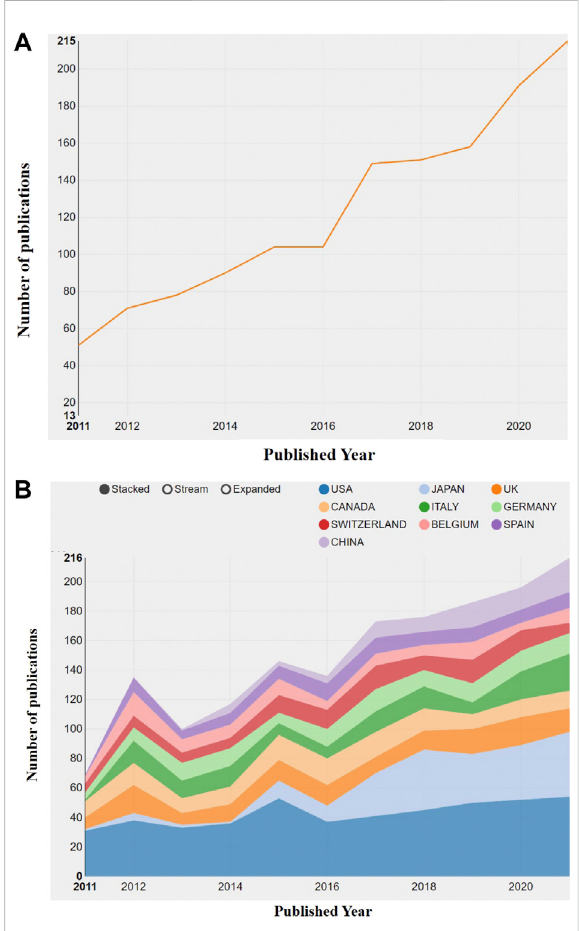
FIGURE 2 Visualdiagramofannualpublicationchanges. (A) Overviewof annual publication changes of denosumab-related articles from 2011 to 2021. (B) Overview of annual publication changes in the top10countriesinthe fi